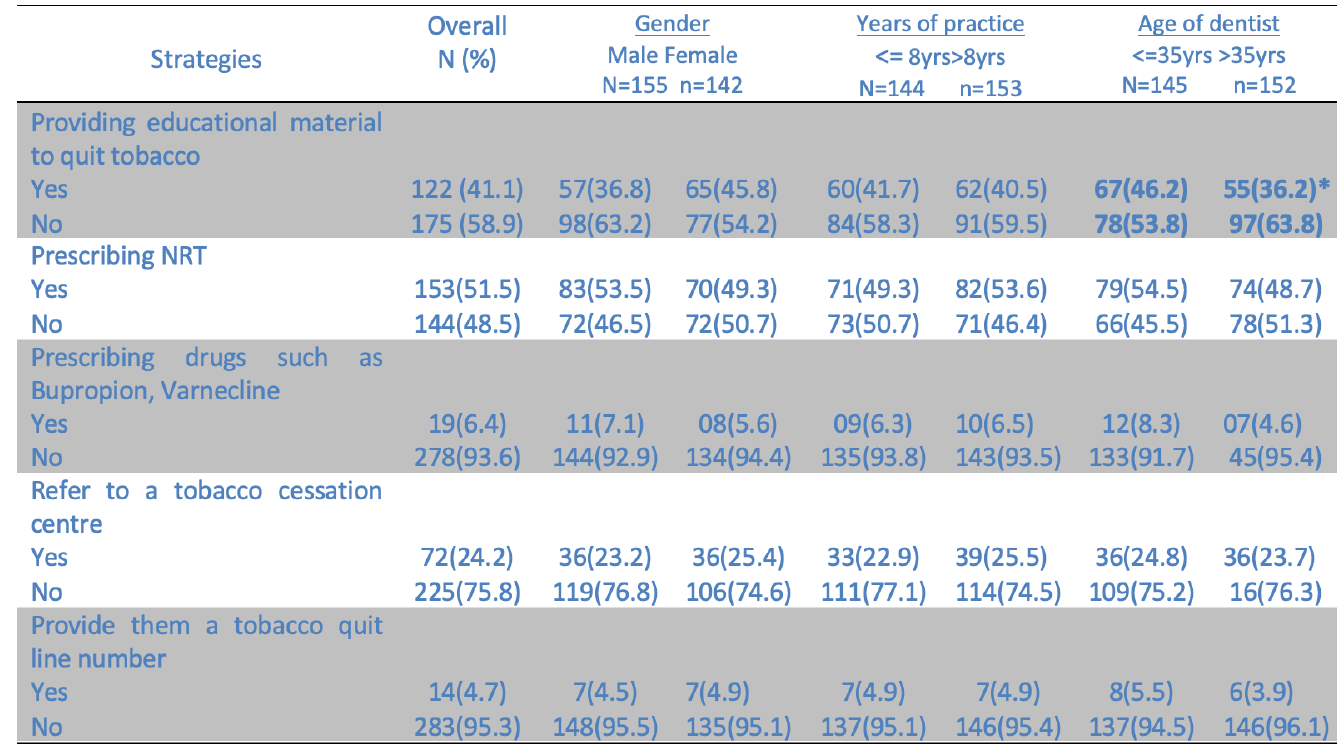
Table 4. Strategies uDlized by the parDcipaDng denDsts for helping their paDents to quit tobacco.